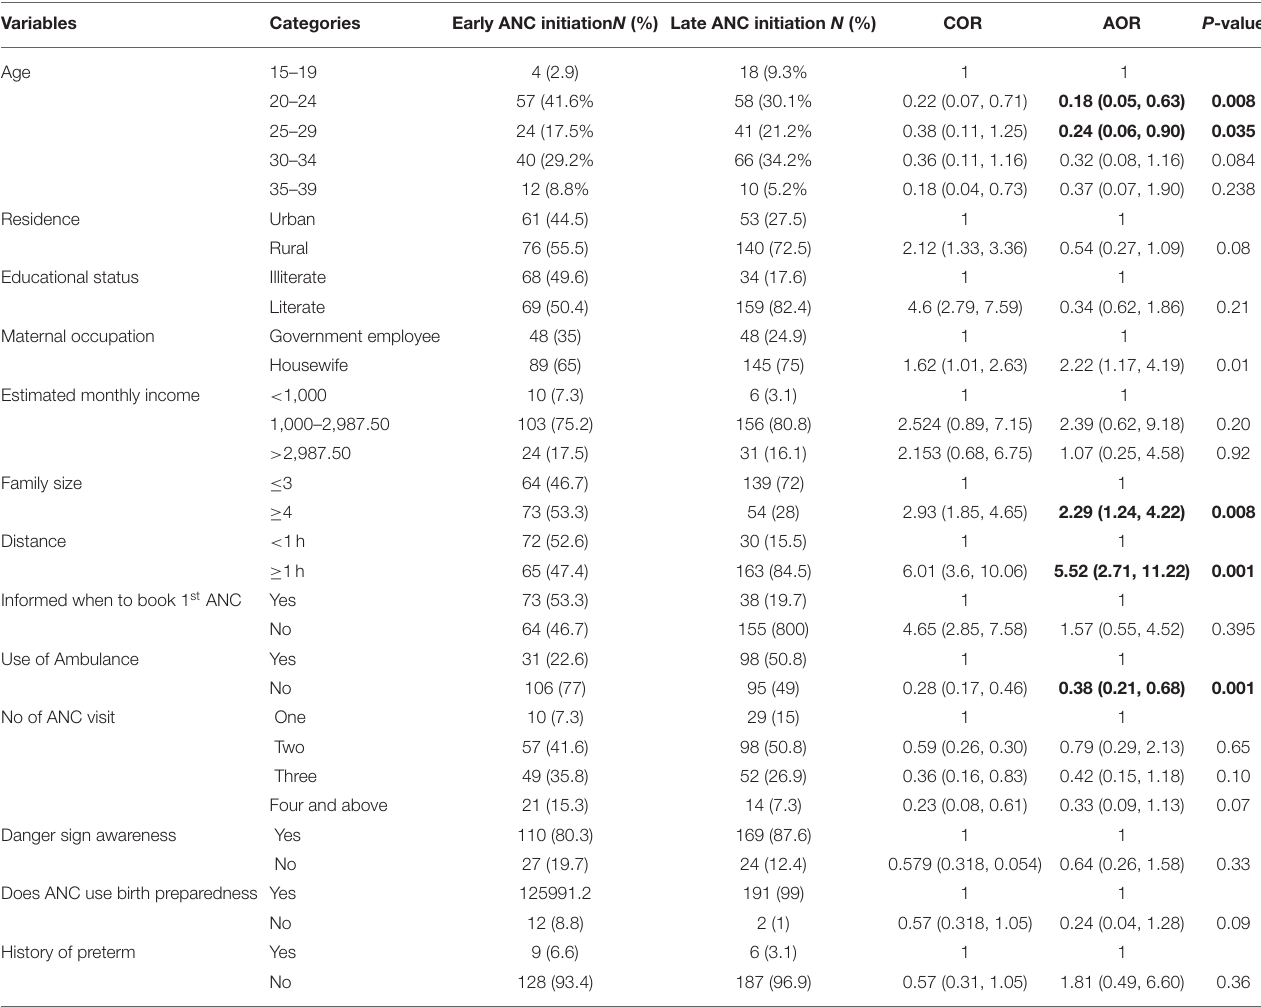
TABLE 3 | Multivariable model of the factors for late ANC initiation among pregnant women attending Gedo Primary Hospital, West Shoa Zone, Oromia region, Ethiopia,